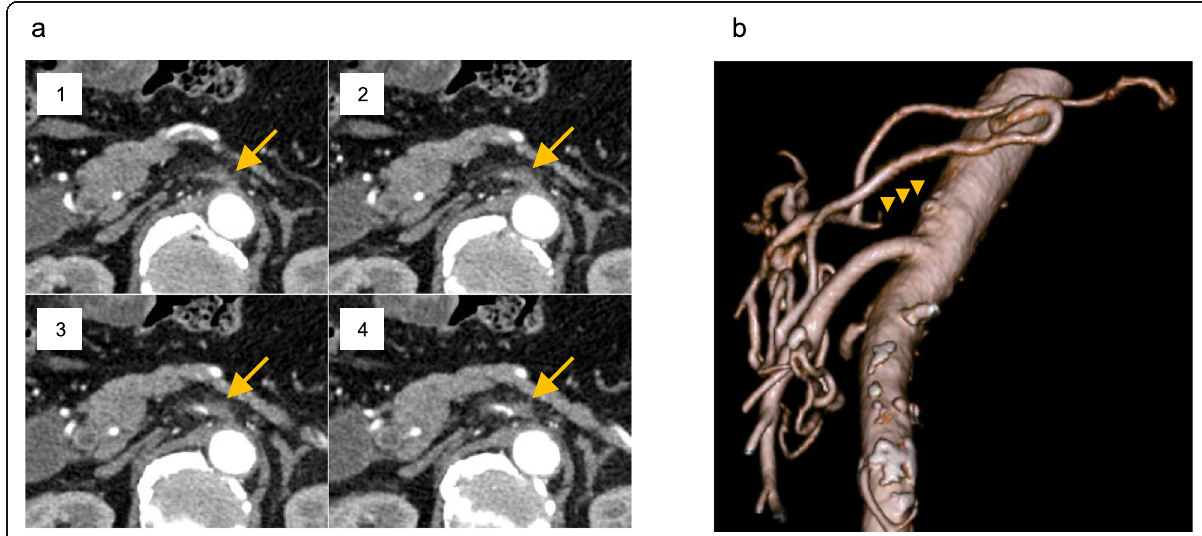
Fig. 2 Serial axial view and three-dimensional reconstruction of the CA using the preoperative MDCT. a Serial axial view of the preoperative MDCT. Complete occlusion of the CA was found (arrow). Images are shown from the cranial to the caudal section in the order from 1 to 4. b Three-dimensional reconstruction of the preoperative MDCT. The CA was completely disrupted (arrow heads). CA, celiac artery; MDCT,